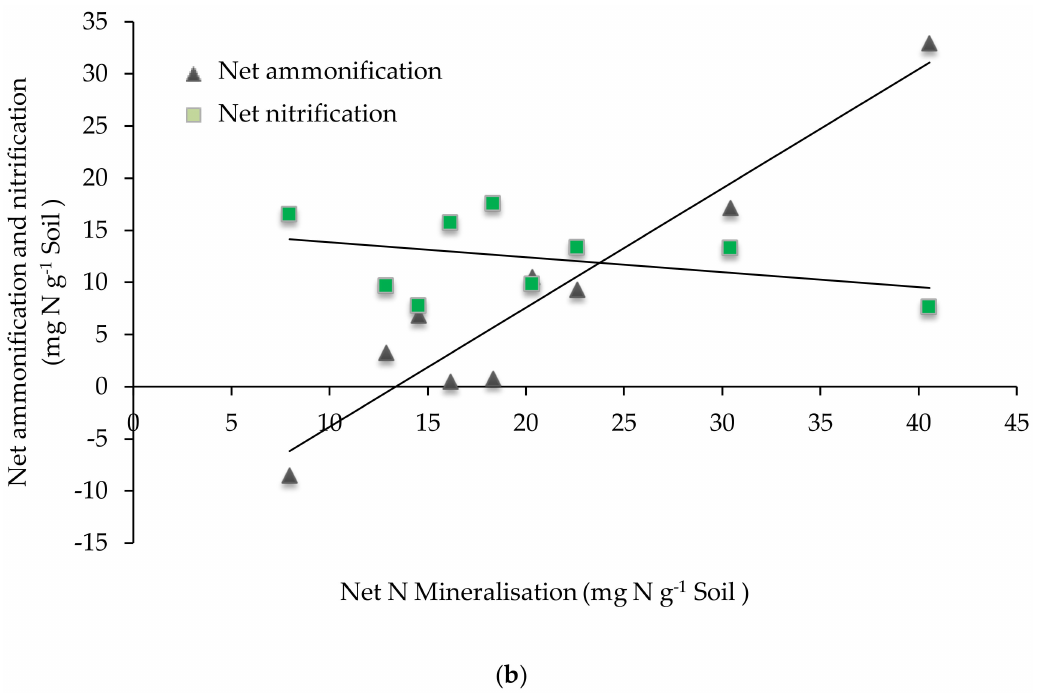
Figure 3. Rates of nitrogen (N) transformation obtained from incubation measurements from soil taken from nine sites. ( a ) Rates of ammonification (mg N g − 1 soil); as the conversion of C and N (%) into NH 4 + ; and the rates of nitrification (mg N g − 1 soil); as the conversion of NH 4 + into NO 3 − . One standard error ( + and − ) is shown for each site measurement. ( b ) Relationship between net N mineralisation rates and net ammonification and net nitrification rates from soil collected from the nine sites.